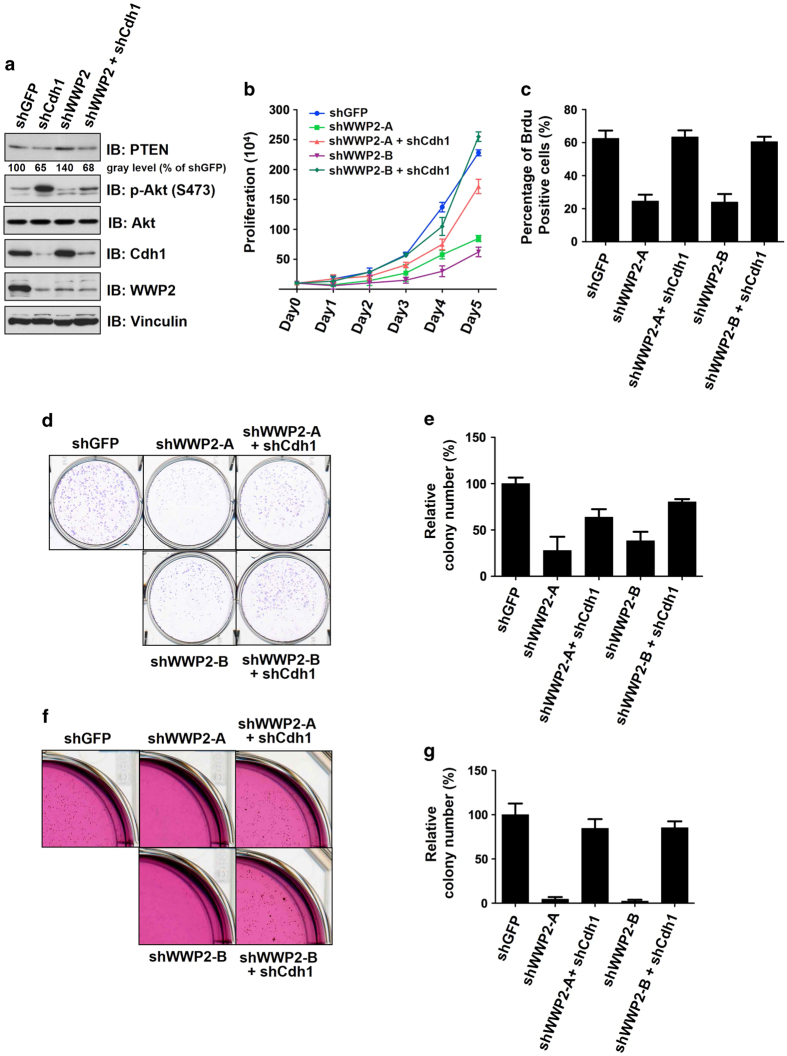
Cdh1 suppresses tumorigenesis partly through modulating the WWP2/PTEN/Akt signaling pathway. (a) IB analysis of MDA-MB-231 cells infected with the indicated lentiviral shRNA constructs. The infected cells were selected with 1 μg ml−1 puromycin for 72 h to eliminate the noninfected cells before collecting for IB analysis. (b) MDA-MB-231 cells stably infected with the indicated lentiviral shRNA constructs were seeded 100 000 cells per well. Afterwards, the cell numbers were counted every day for 5 days to monitor cell proliferation. The data shown are derived from three independent experiments (mean±s.d., P<0.05, Student’s t-test, compared with cells expressing control shGFP). (c) BrdU labeling analysis was performed using MDA-MB-231 cells that were stably infected with the indicated lentiviral shRNA constructs. The cells were seeded 50 000 cells per well; 24 h later, the cells were incubated with BrdU and uridine for 48 h before photographs were taken. Percentage of BrdU positive cells was illustrated as mean±s.e.m. (n=3). (d, e). MDA-MB-231 cells stably infected with the indicated lentiviral shRNA constructs were seeded 10 000 cells per well. Seven days later, crystal violet was used to stain the formed colonies before photographs were taken (d). Colony numbers were counted from three independent experiments and the relative colony numbers were calculated as mean±s.e.m. (n=3) in e. (f, g) MDA-MB-231 cells stably infected with the indicated lentiviral shRNA constructs were seeded (3 000 cells per well) in 0.5% low-melting-point agarose in DMEM with 10% FBS and layered onto 0.8% agarose in DMEM+10% FBS. The plates were cultured for 30 days before photographs were taken (f). The colonies >50 μm were counted under a light microscope. The relative colony numbers were plotted as mean±s.e.m. from three independent experiments (g). BrDU, bromodeoxyuridine; DMEM, Dulbecco’s Modified Eagle’s medium; IB, immunoblotting; FBS, fetal bovine serum; shRNA, short hairpin RNA.